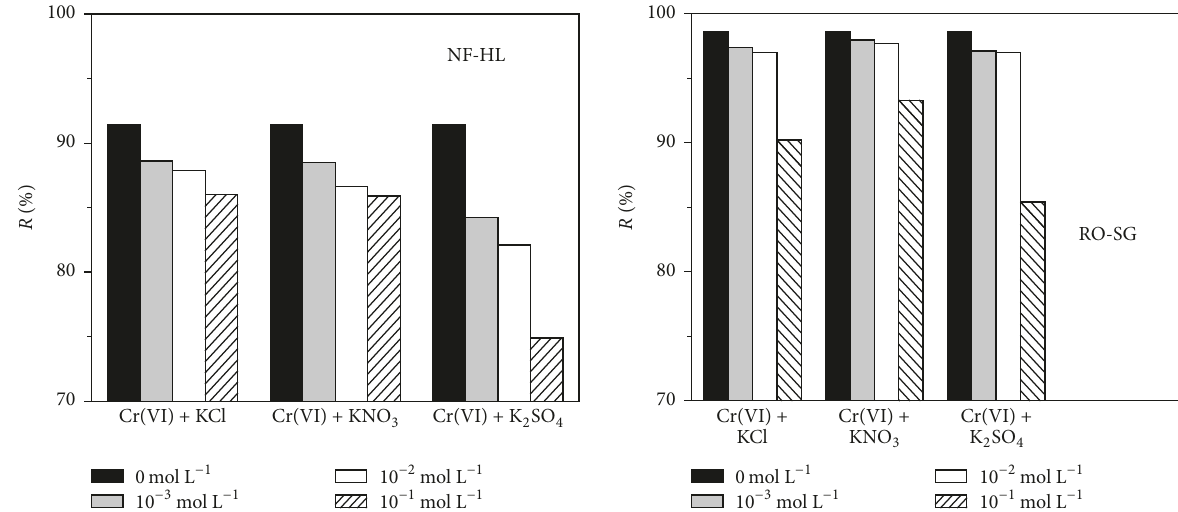
Figure 4: Effect of the ionic strength and coexisting ions on the retention rate of Cr(VI) ( 𝐶 Cr ( VI ) = 50 mg L −1 , 𝑌 = 50%, Δ𝑃 = 6 bars, pH = 8, and 𝜃 = 25 ∘ C).